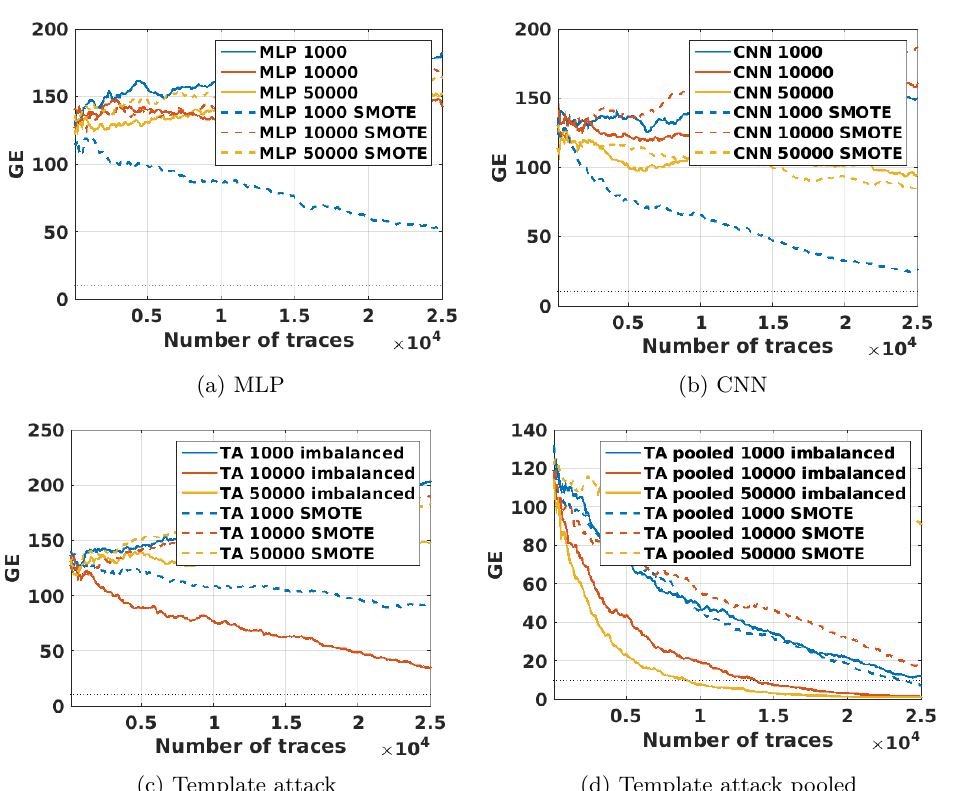
Figure 6: Guessing entropy for imbalanced and SMOTE on AES_RD, deep learning and template